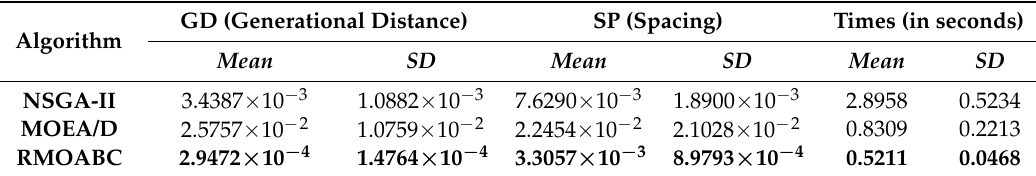
Table 3. Results of the performance metrics for ZDT2 function of the algorithms.